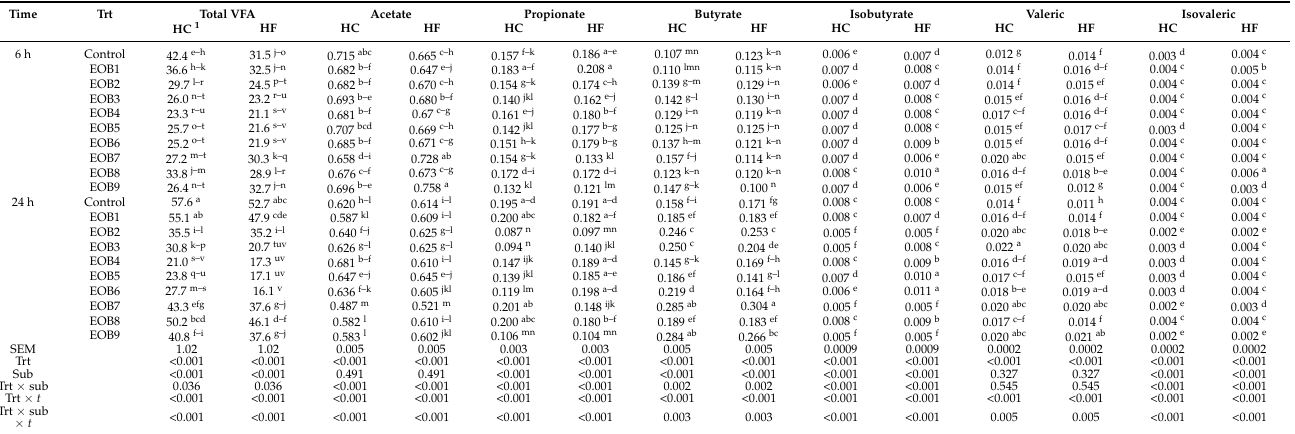
Table 5. Effects of the essential oil blends (EOBs), time, and substrates on total and molar proportion of volatile fatty acids (VFA, mM) production ( n =